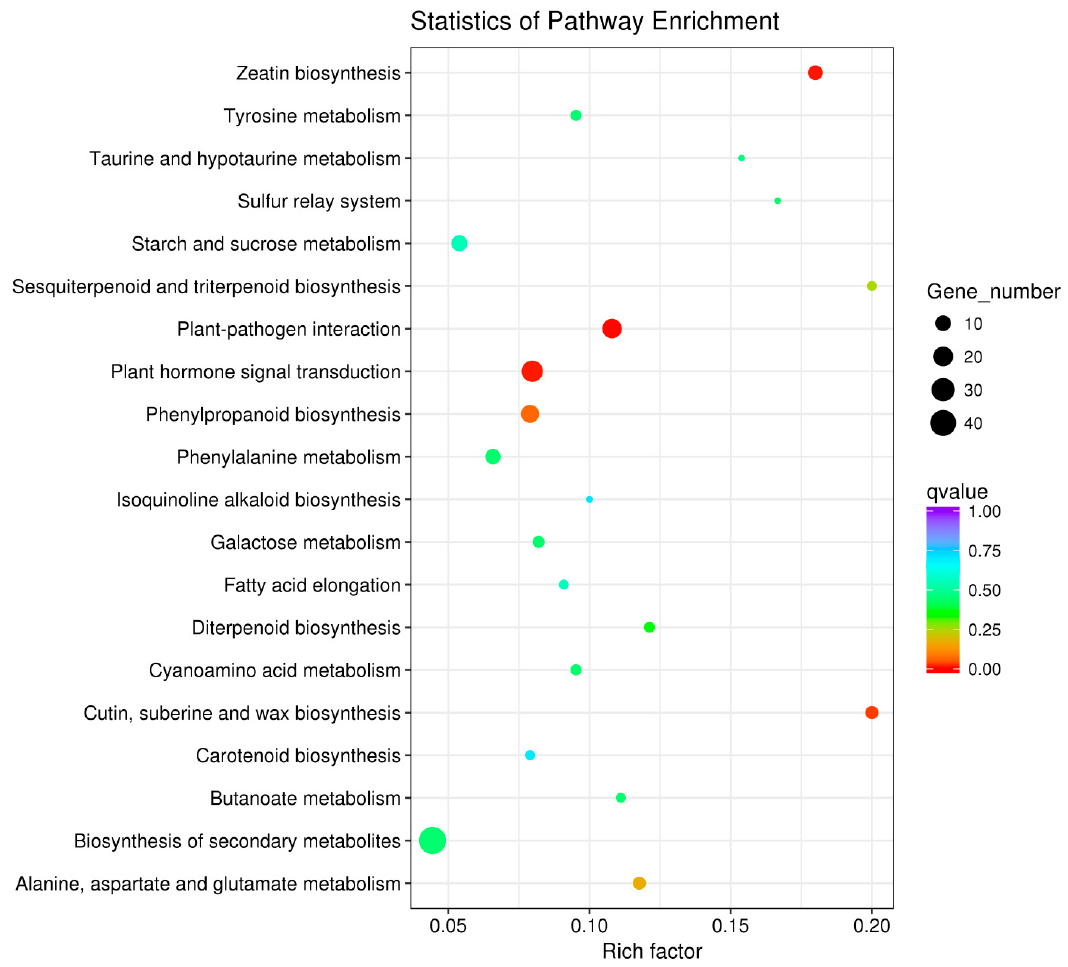
Figure 3. KEGG pathway enrichment analysis of DEGs T2 and CK treatments. The left Y-axis shows the KEGG pathway. The X-axis shows the Rich factor. A high q -value is represented by blue and a low q -value is represented by red ( q < 0.05).